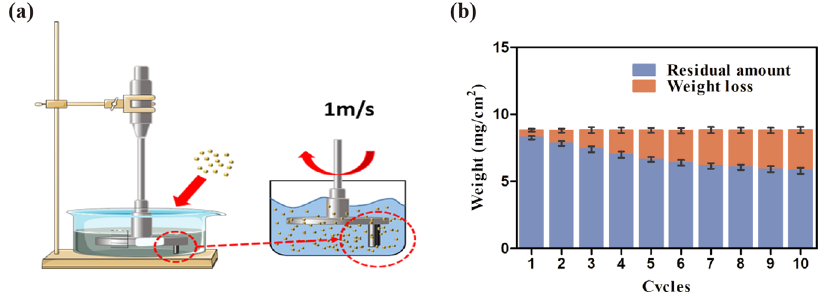
Fig. 8 Wear resistance of S. putrefaciens -induced mineral layers. a Schematic illustration of wear-resistance testing equipment; b weight loss of the coupons after different testing cycles.